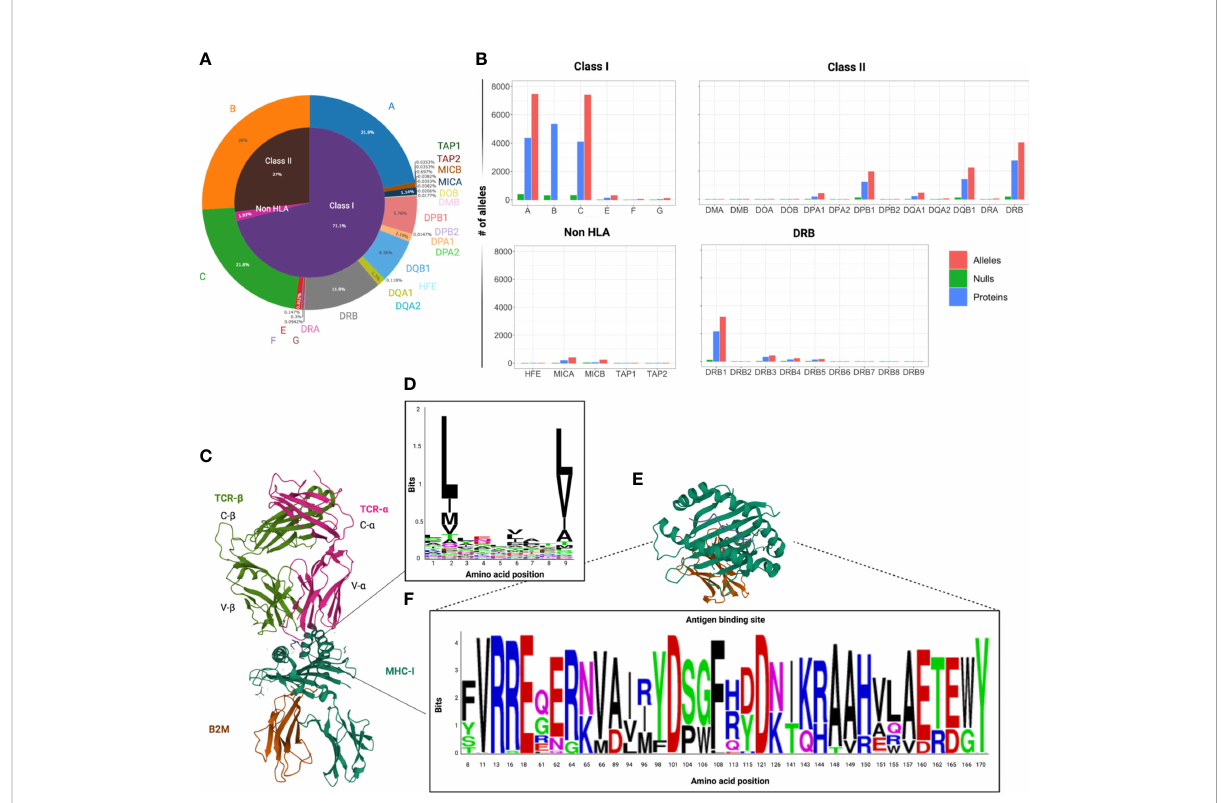
FIGURE 1 Variability of HLA locus. (A) Circle graph capturing the distribution of the number of HLA class I, class II and non-HLA alleles known to date within the human MHC region. Data extracted from the IPD-IMGT/HLA database v.3.48, downloaded in July 2022. (B) Bar graphs depicting the distribution of the number of alleles, proteins and null alleles (characterized by the presence of truncating mutations), per locus among classical and non-classical HLA genes. Of note is that HLA-DRB1 is responsible for the greatest variability within the copy number-variable DRB locus. (C) 3D crystallographic structure of TCR ab chains interacting with an MHC class I molecule (allele A*02:01 and b 2 microglobulin – b 2M). These structures were extracted from the Protein databank (PDB) website and reoriented in order to show MHC-TCR synapsis (ref PDB:4MNQ) (10). (D) Representation of the HLA binding motifs of selected epitopes from a HLA-A2 related dataset, extracted from the IEDB (11) an visualized with Weblogo (https://weblogo.berkeley.edu ) (E) Crystallographic structure of the antigen binding domains of HLA-A*01:01 with some variable residues highlighted. (F) WebLogo visualization of the variable amino acids within the peptide binding domains (corresponding to exon 2 and 3) of the HLA-A alleles in a representative population of healthy controls (N=960). (12) The height of each letter corresponds to the relative frequency of each amino acid in the population. This graphic represents an attempt to visualize the variability of the antigen binding domain of HLA-A alleles, but does not capture the whole spectrum of heterogeneity, since it represents only a limited